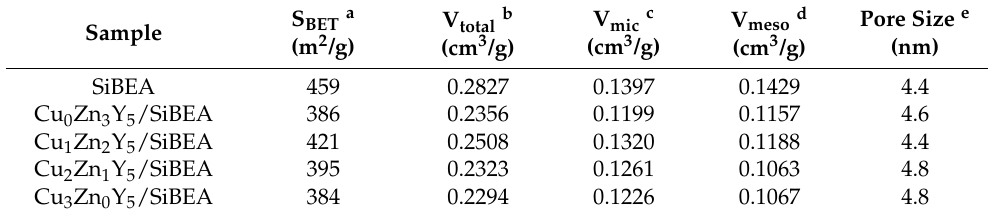
Table 1. Specific surface area, pore volume, and pore size of SiBEA carrier and CuZnY/SiBEA catalysts.